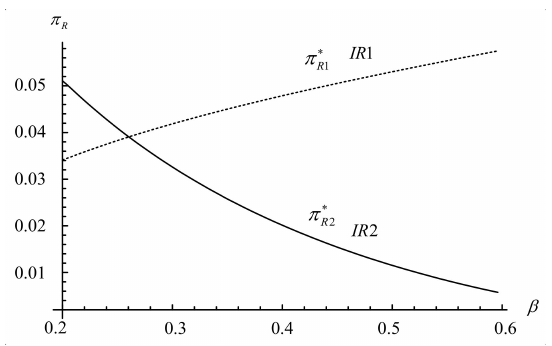
Figure 5. Impact of β on the IR’s